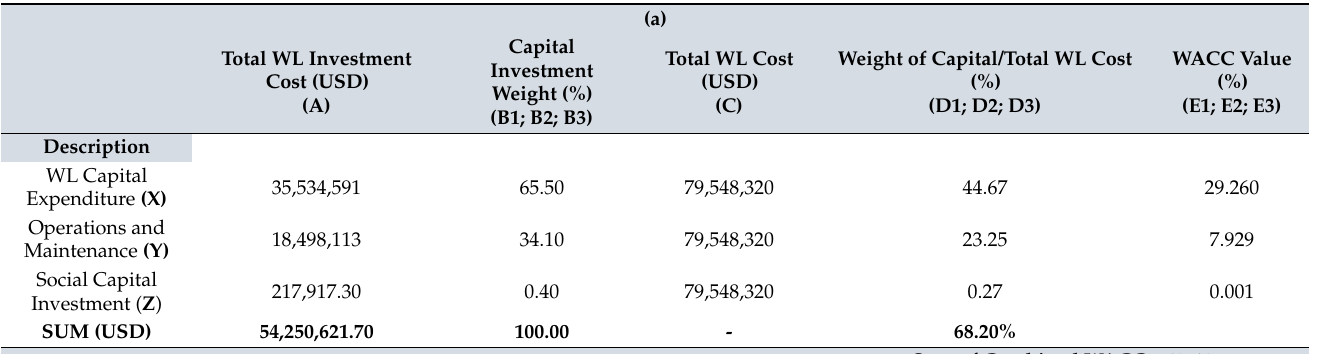
Figure 8. Socio-technical approach of integrated weighted average cost of capital (WACC) and capital net risk outlook. WL: water loss. Table 7. ( a ) Weighted cost of capital for combined socio-technical water loss reduction; and ( b ) sensitivity analysis for weighted average cost of capital (WACC) concerning socio-technical water loss (WL) reduction.